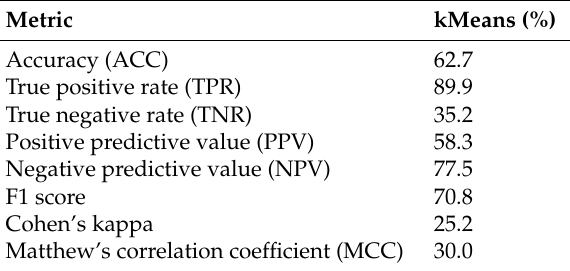
Table 5. Phase 1: Unsupervised machine learning